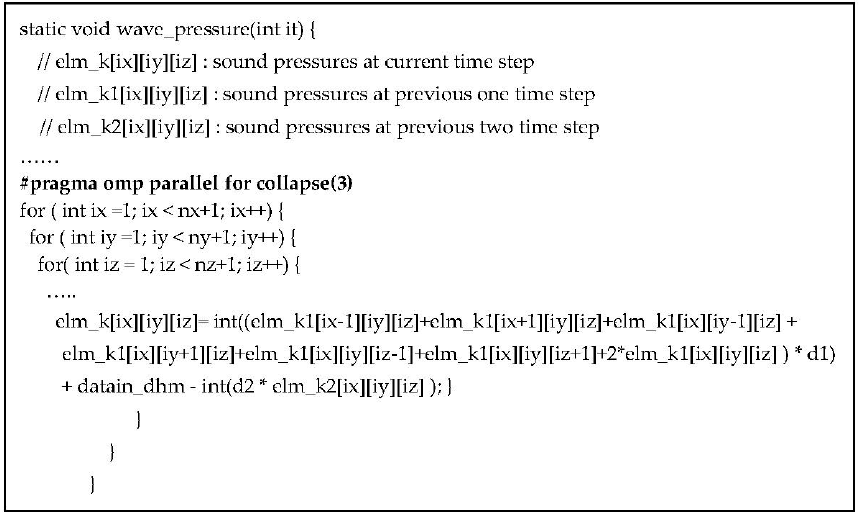
Figure 8. Snapshot of the computation module.